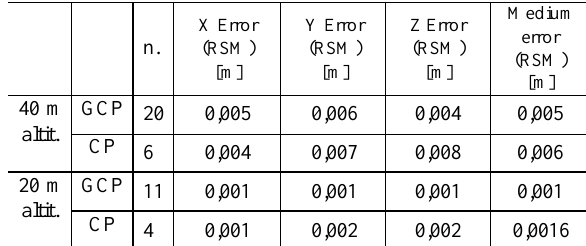
Figure 6. Nadiral set of strips in green (20 m altitude), oblique opposite strips in red (6m from the ground), terrestrial strips in light blue (almost 3m distance) with dense cloud.